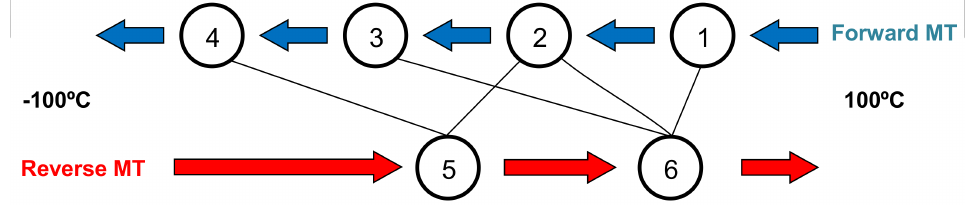
Figure 5. Summary of the relationships between the six MT